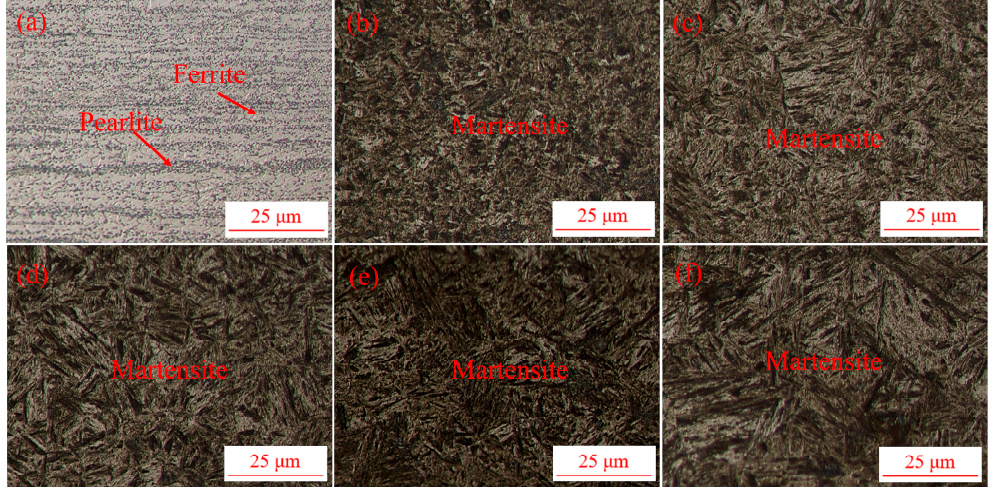
Figure8. Microstructuresofthehot-stampingsteelafterdi ff erentaustenitizingtemperatures: ( a )original Figure 8. Microstructures of the hot-stamping steel after different austenitizing temperatures: ( a ) sample, ( b ) 840 ◦ C, ( c ) 900 ◦ C, ( d ) 930 ◦ C, ( e ) 960 ◦ C and ( f ) 990 ◦ original sample, ( b ) 840 °C, ( c ) 900 °C, ( d ) 930 °C, ( e ) 960 °C and ( f ) 990 °C.